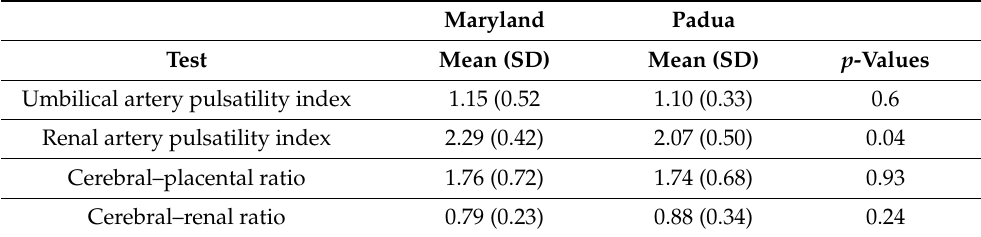
Table 3. Comparison of Doppler parameters for each